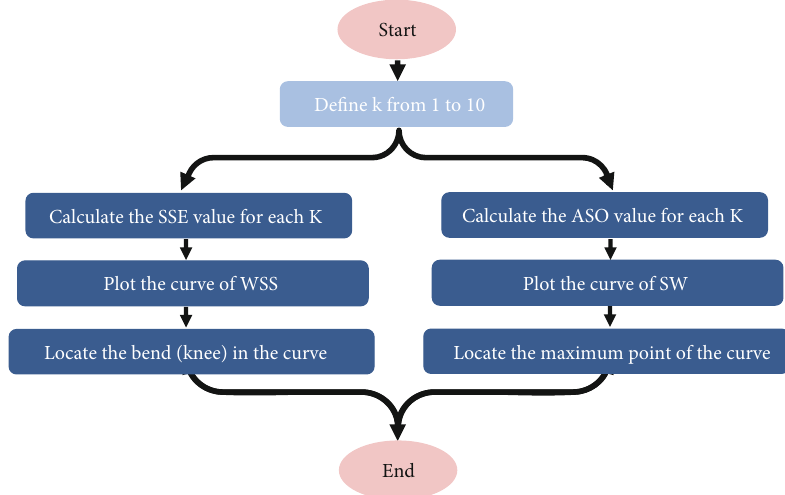
Figure 5: Flowchart of the elbow and the average methods.